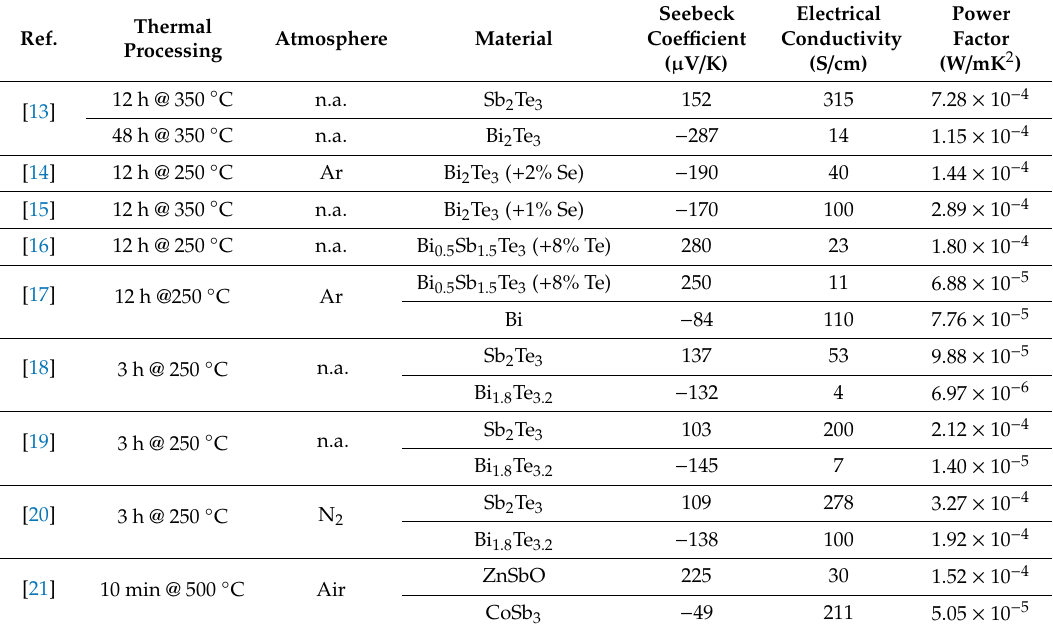
Table 2. Overview of previous work on bismuth telluride materials that were thermally post treated in